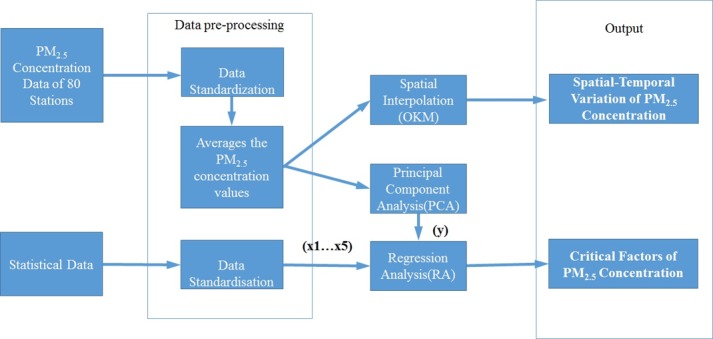
Research framework.